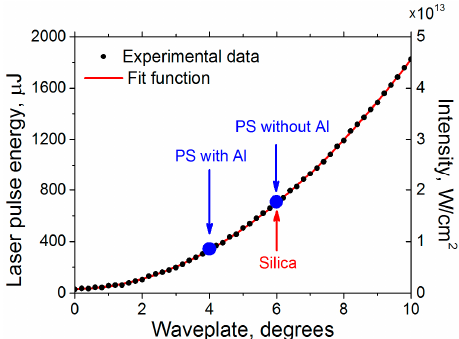
Figure 3. The infrared (IR) laser energy calibration curve. The maximum of the IR laser energy used